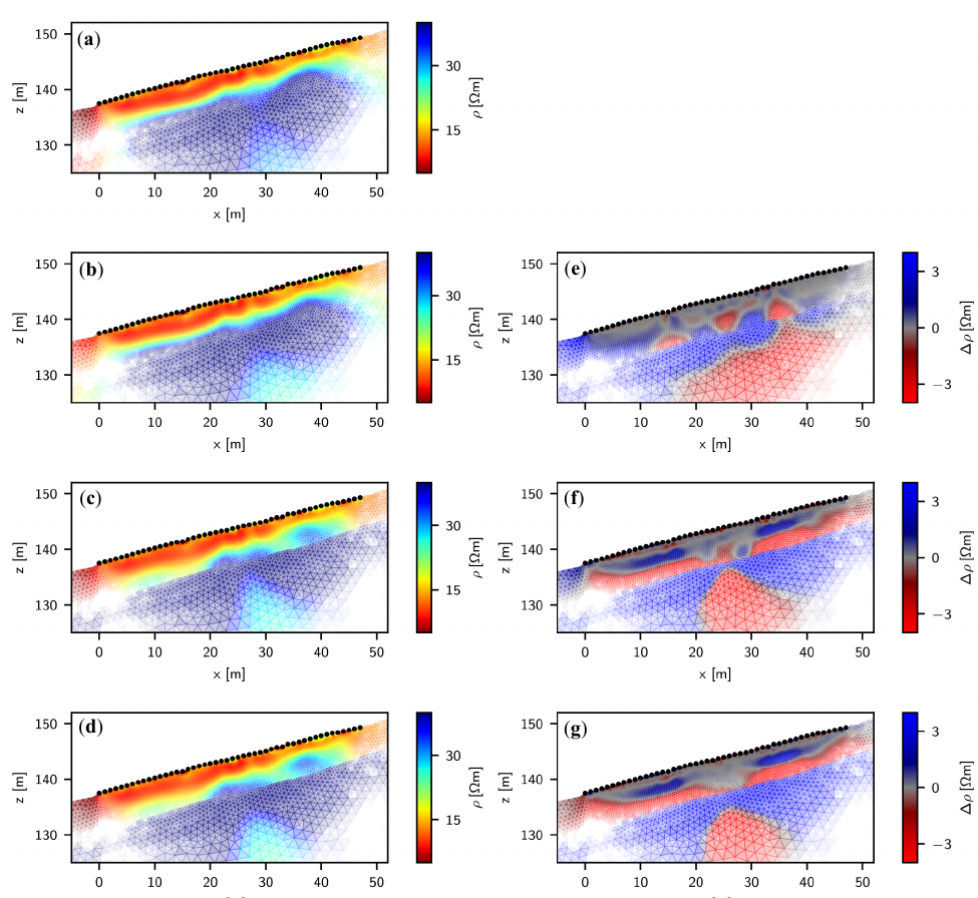
Figure 6. Resistivities ( a – d ) and resistivity differences ( e – g ) compared to the fully smoothed inversion with varying coupling coefficients ( η = 1,0.5,0.05,0.005 from top to bottom row). The colorbar is limited to 40 Ω m to focus on the heterogeneity of the upper layer, but the resistivity in the lower layer reaches up to 100 Ω